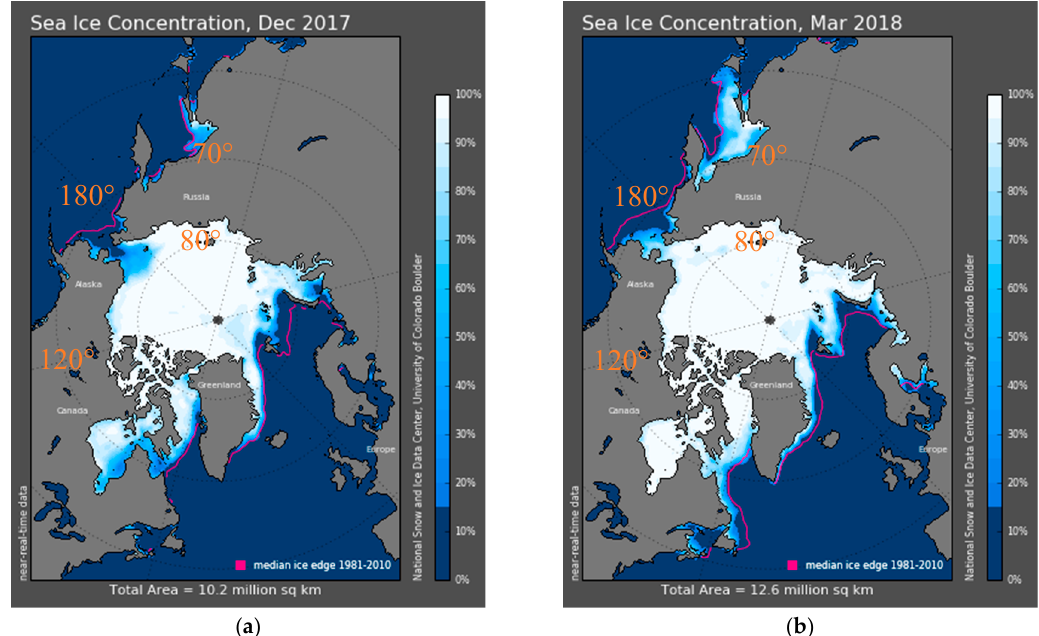
Figure 13. Arctic sea ice concentration reported by the National Snow and Ice Data Center [43], University of Colorado Boulder on ( a ) December 2017 and ( b ) March 2018. Ice concentration remains constant since December to March. Images courtesy of the National Snow and Ice Data Center (NSIDC), University of Colorado, Boulder. The images are derived from Sea Ice Index NSIDC data product, which relies on NASA-developed methods using passive microwave data from the Defense Meteorological Satellite Program (DMSP) F-18 Special Sensor Microwave Imager / Sounder (SSMIS). The Sea Ice Index [44] was developed by the NSIDC with financial support from NOAA NESDIS and in cooperation with NOAA NGDC. Color scale from 0% (dark blue) to 100% (white) on 10% increments.